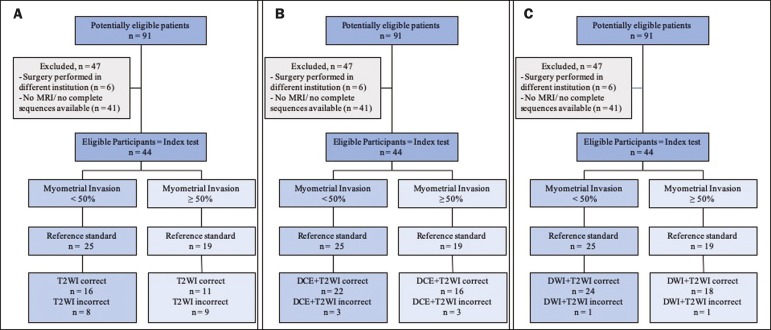
Flow of participants through the study, including the acquisition of
the MRI sets T2WI (A), DCE+T2WI (B), and
DWI+T2WI (C).